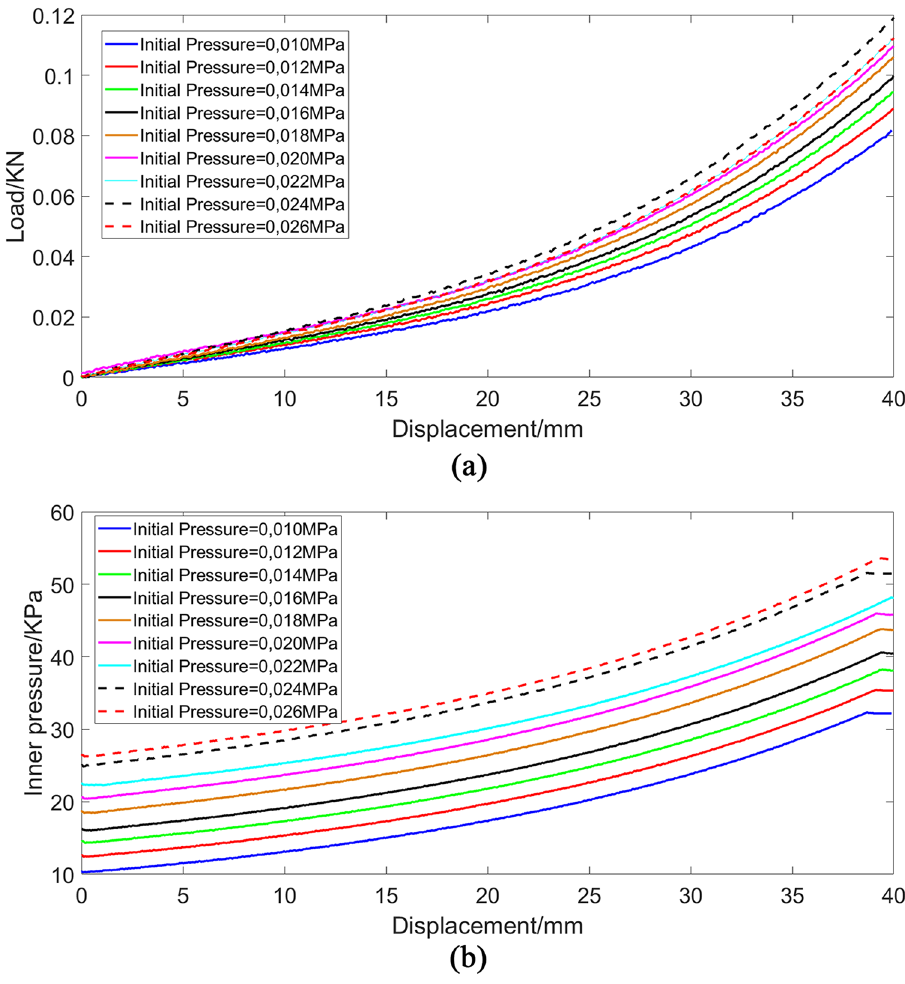
Fig. 4. Load and internal pressure during compression. (a) Load curve, (b) internal pressure curve.